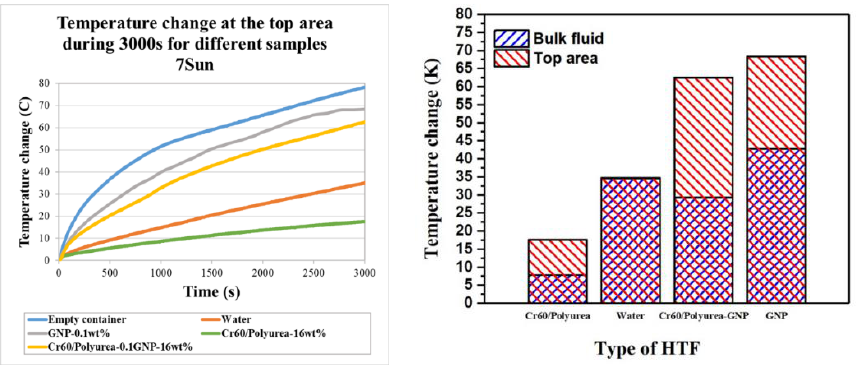
Figure 10. Temperature change difference of Cr60@polyurea-0.1%GP samples.